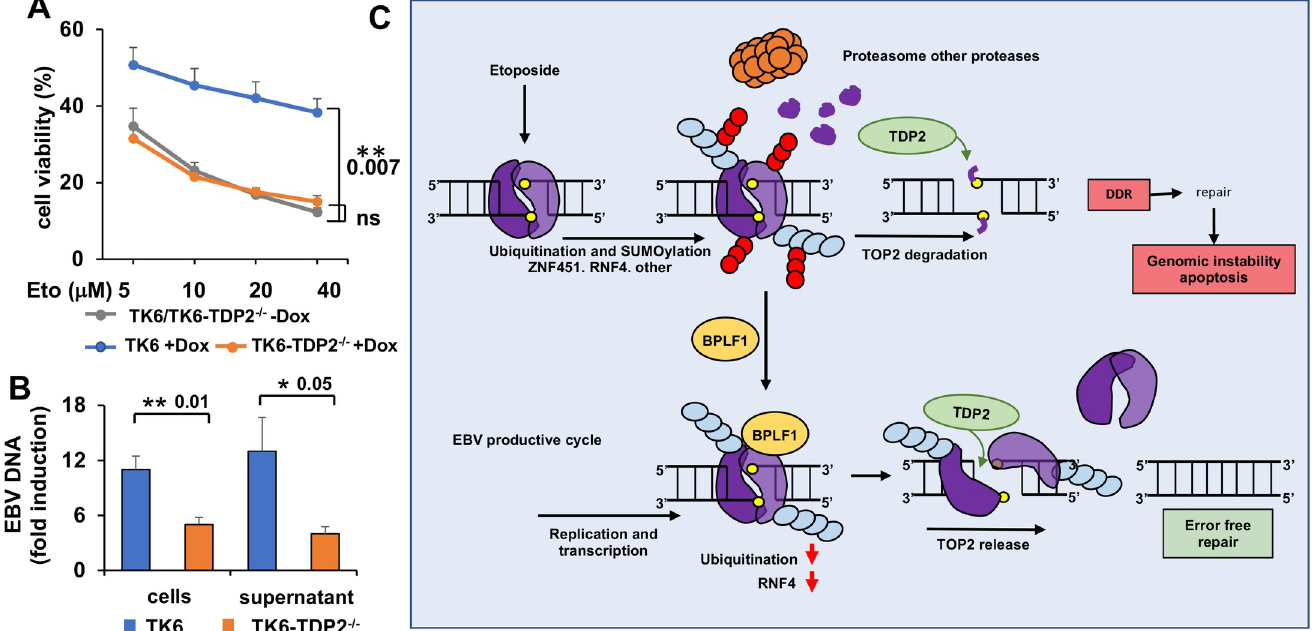
Fig 7. TDP2 is required for resistance to Etoposide toxicity and virus production in induced LCLs. The productive virus cycle was induced in TK6 and TK6-TDP2 -/- LCLs expressing a tetracycline regulated BZLF1 transactivator by treatment with 1.5 μ g/ml Dox. ( A ) TK6/TK6-TDP2 -/- LCLs were harvested 72 h after induction. Five x10 4 live cells were seeded in triplicate wells of 96 well plates and treated overnight with the indicated concentration Etoposide before assessing cell viability by MTT assays. The rescue of Etoposide toxicity observed in induced TK6 was abolished in cells lacking TDP2. The mean ± SE of cell viability in three independent experiments is shown. �� P � 0.01. ( B ) The amount of EBV-DNA in cell pellets and DNAse treated culture supernatants was quantified by qPCR 72 h after induction. The mean ± SE fold induction relative to untreated controls in three (supernatants) or four (cells) independent experiments is shown. � P � 0.05, �� P � 0.01. (C) Model of TOP2 regulation by BPLF1. TOP2 (violet) trapped in TOP2ccs (yellow) is targeted for proteasomal degradation via SUMOylation (light blue) and ubiquitination (red) mediated by the SUMO ligase ZNF451, the SUMO-targeting ubiquitin ligase RNF4 and other cellular ubiquitin ligases, leading to the display of partially digested 5’-phosphotyrosyl-DNA adducts. Processing by the TDP2 resolvase generates protein-free DSBs that trigger the DDR. Imprecise repair leads to apoptosis and genomic instability. Ectopically expressed BPLF1 is recruited to DNA-trapped TOP2 and inhibits proteasomal degradation, which prevents the activation of the DDR. In the absence of ubiquitination, SUMOylation may alter the conformation of the TOP2 dimer allowing direct access of TDP2 to the 5’- phosphotyrosyl-DNA bonds, which promotes error-free repair. During productive EBV infection, the concomitant expression of BPLF1 and viral miRNA mediated downregulation of RNF4 favors the accumulation of SUMOylated TOP2 β and the activation of non-proteolytic pathways for TOP2ccs debulking that are dependent on the resolution of TOP2-DNA adducts by TDP2. This promotes the error free repair of TOP2-induced DSBs and enhances cells survival and virus production.